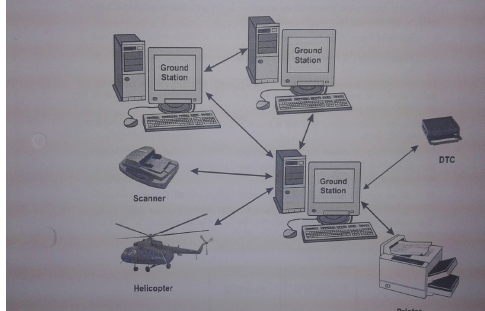
Figure 11 – System block diagram of the MMS Рис . 11 – Система структурной схемы MMS Слика 11 – Систем блок - шема на